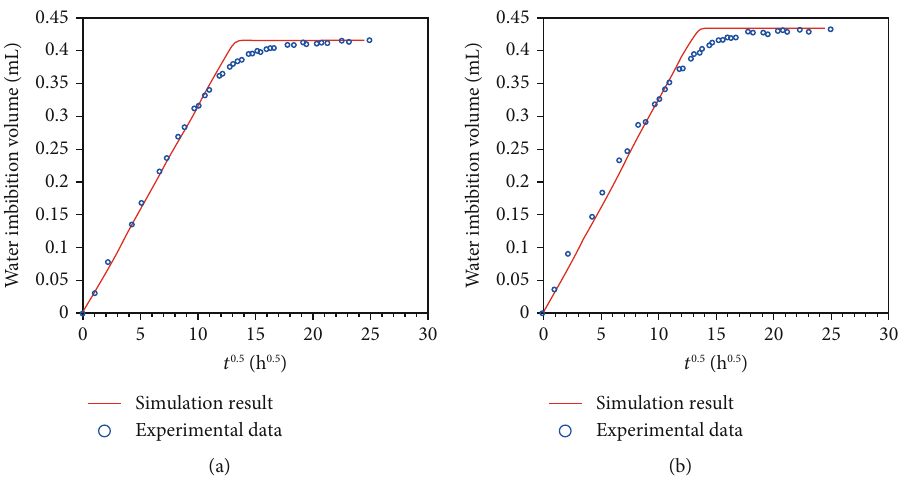
Figure 6: The variation of water imbibition volume with square root of time ((a) is for sample A and (b) is for sample